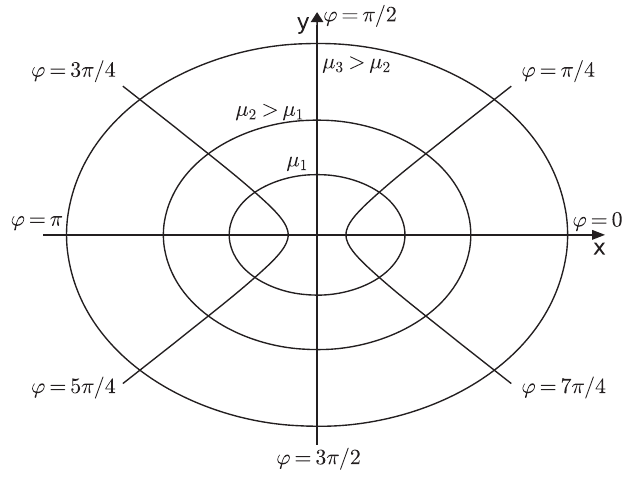
FIG. 1. Elliptic coordinates. The φ coordinate describes a series of hyperbolas having the same foci. The μ coordinate describes confocal ellipses centered in the origin of the coordinate